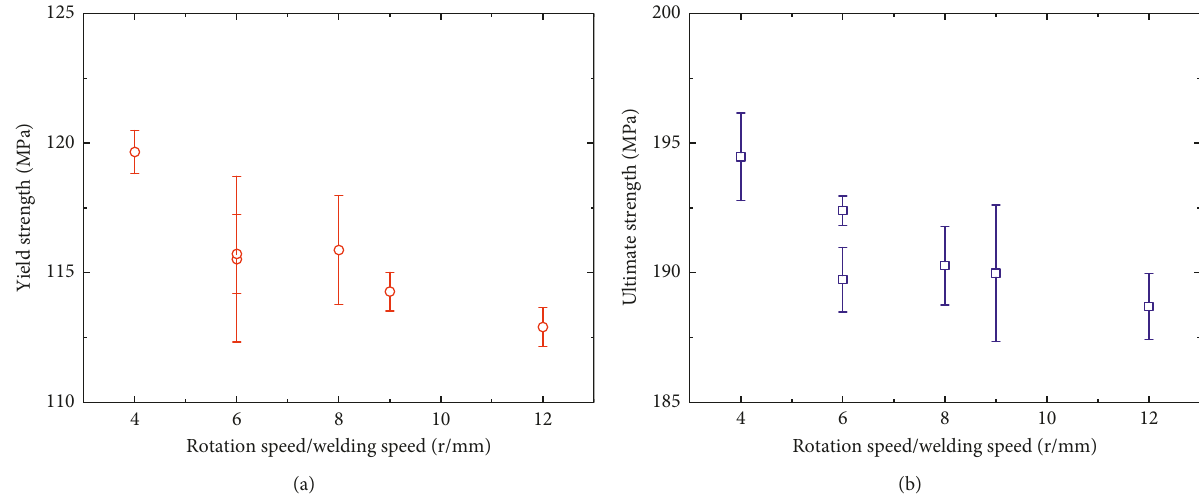
Figure 3: The variation of (a) yield strength and (b) ultimate tensile strength with the ratio of rotation speed to welding